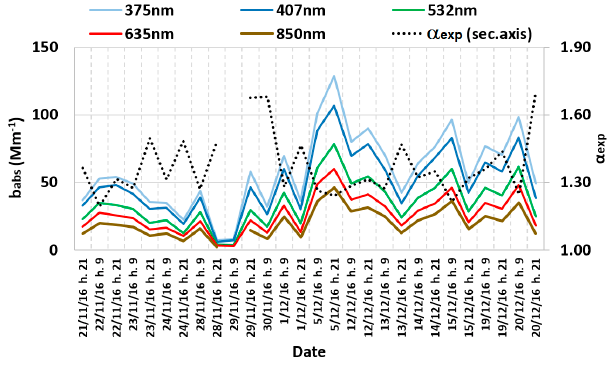
Figure 6. 5- λ b abs and α exp determined on the Milan dataset. Date and time referring to the beginning of the sampling are reported on the x-axis.